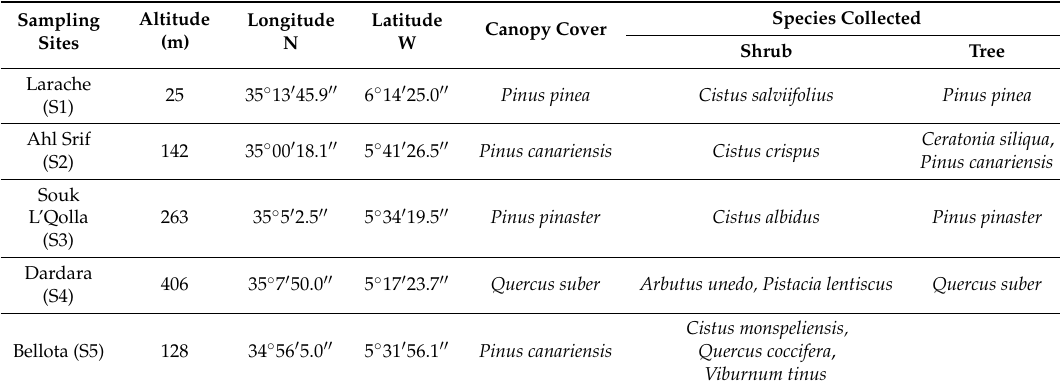
Table 1. Distribution of the collected species among sampling